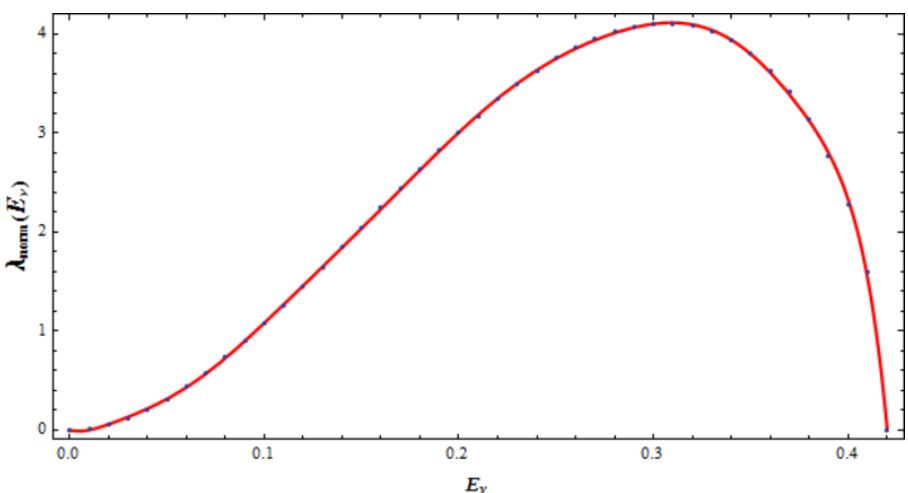
Figure 9 . Normalized pp spectrum d(cid:21)=dE (cid:23) from table IV of ref.